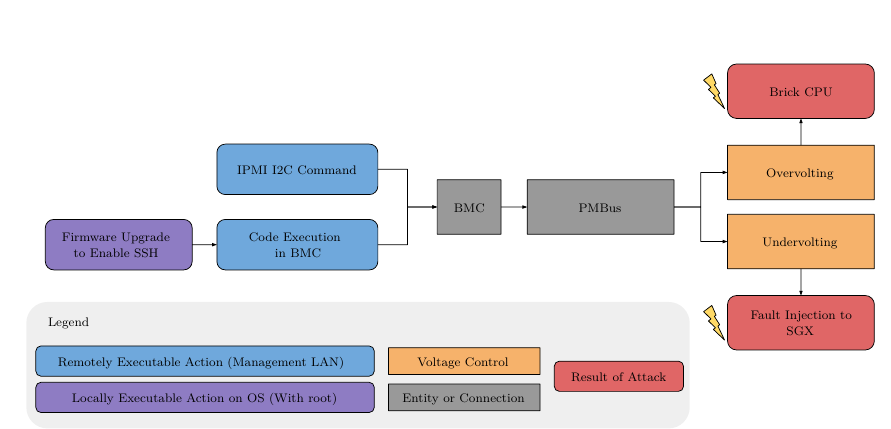
Figure 7: Overview of the PMFault attack. With root access to the OS or access to the BMC via Ethernet or KCS, the attacker can perform a malicious firmware upgrade of the BMC and then takeover the PMBus. The attacker can also use the ipmi i2c command to directly control the PMBus via BMC. With control over the CPU voltage, the attacker can overvolt to brick the CPU or undervolt to inject faults into